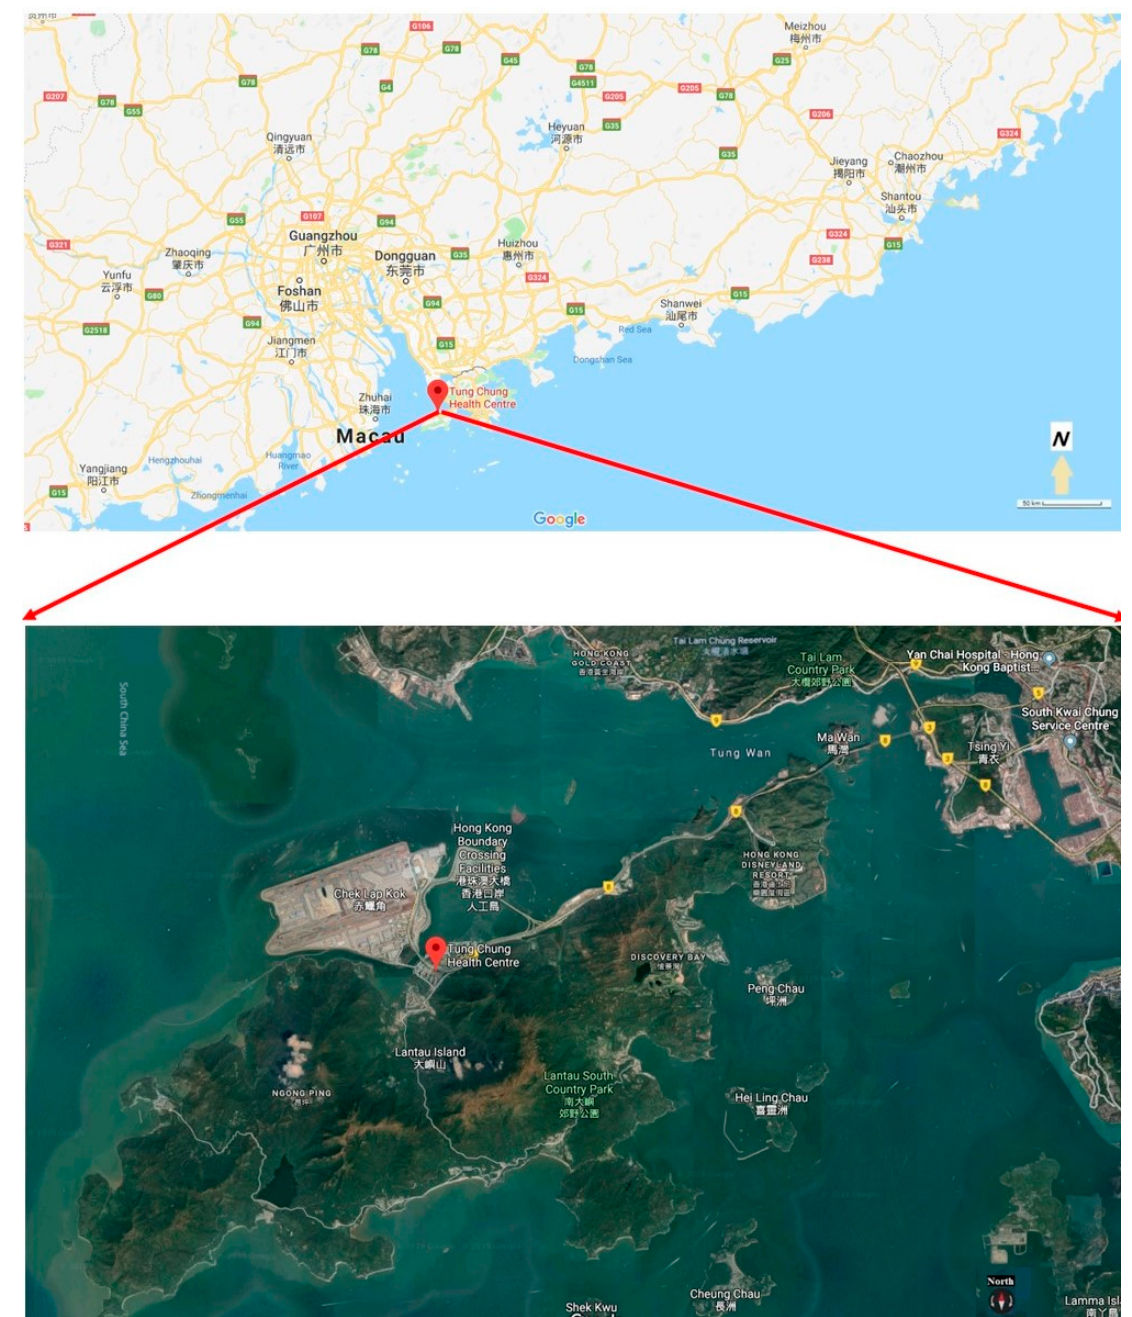
Figure 1. Location of the sampling site. Source: from Google map.